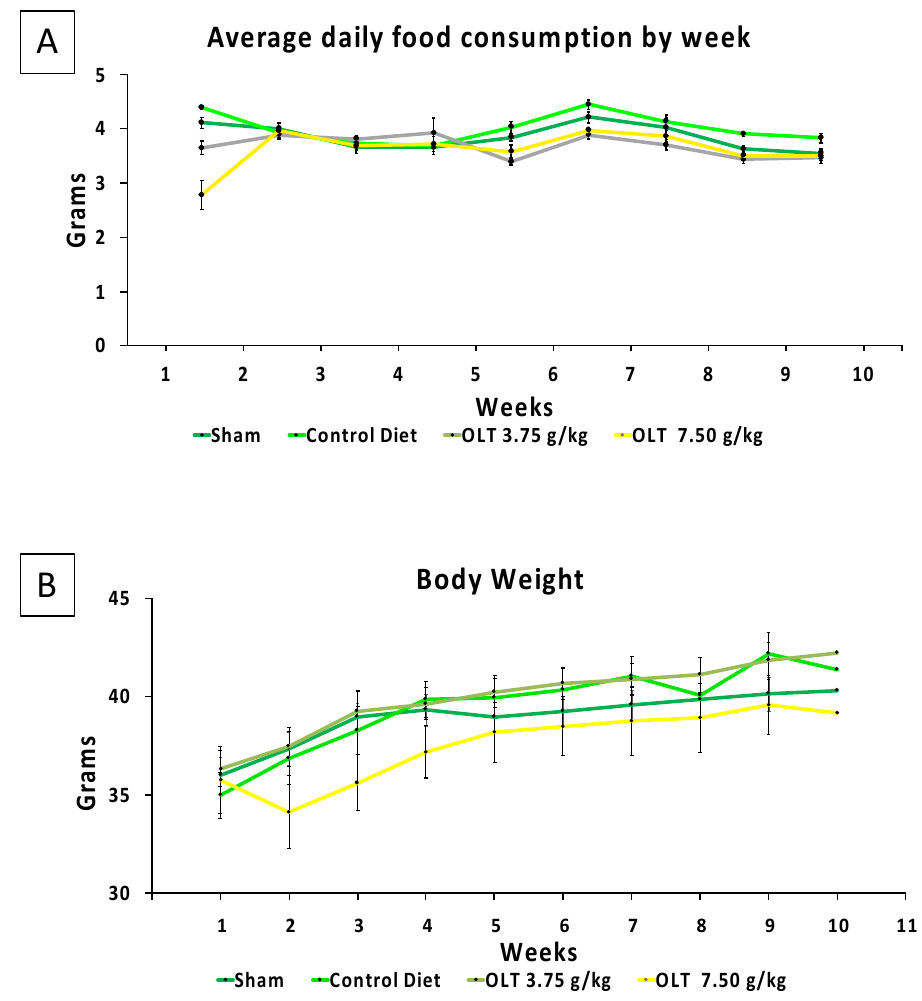
Figure 1. ( A , B ) The diets were administered seven days post-AMI surgery, and the average daily food consumption ( A ) and corresponding body weight ( B ) of the mice groups were measured and recorded during a 9-week experimental period. The values are expressed as the mean ± SEM. The data analysis included all of the mice that survived from the moment of the diet randomization to the end of the study. The number of infarcted segments in each group, as assessed by echocardiography, is reported in Figure 2. As expected, at the baseline, when compared to the sham-operated mice ( n = 6), the mice that underwent AMI surgery had an 18% greater LVEDD ( p < 0.001) and a 57% lower LVEF ( p < 0.001). After 10 weeks, a further increase in LVEDD and decrease in LVEF was noted in the mice fed with the standard diet (Group 3), as well as in those fed with low- and high-dose OLT1177 ® in the diet (Groups 1 and 2, respectively), without significant differences between the groups (Figure